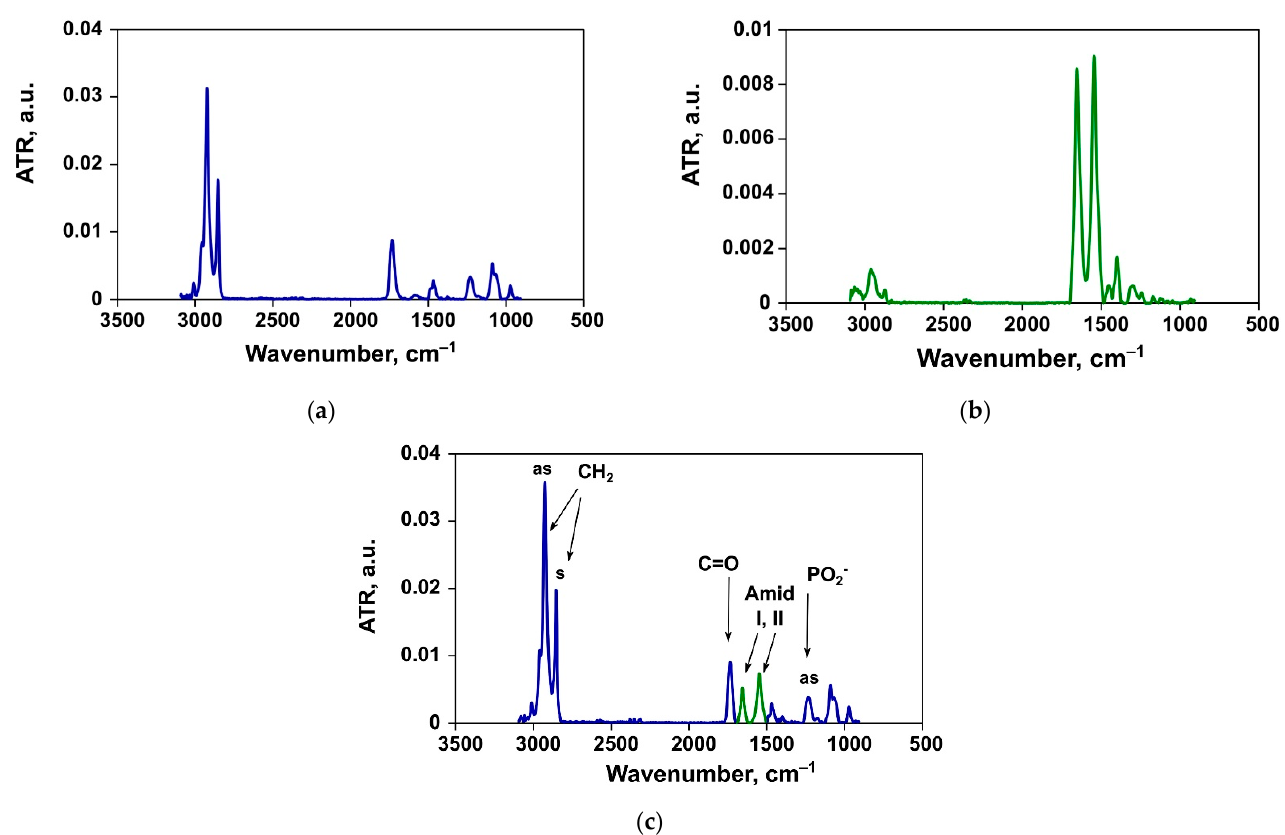
Figure 2. An example of the ATR-FTIR spectrum of ePC liposomes ( a ), bovine serum albumin (BSA) ( b ), and mixture thereof ( c ).